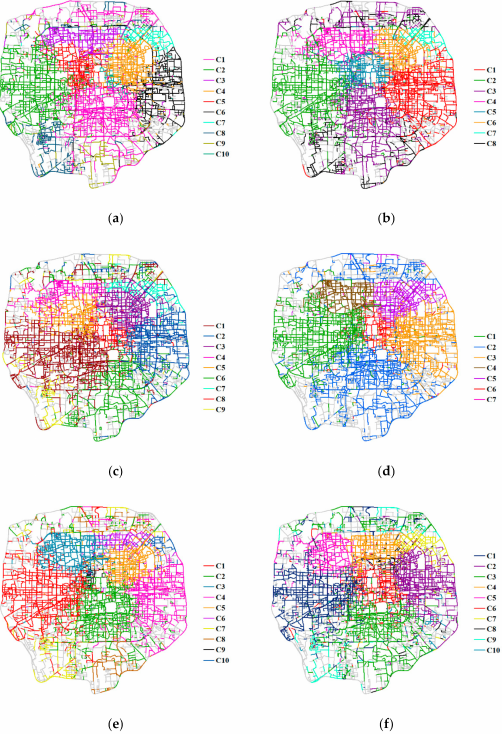
Figure 13. Communities discovered by RWLA: ( a ) 8:00–9:00; ( b ) 9:00–10:00; ( c )